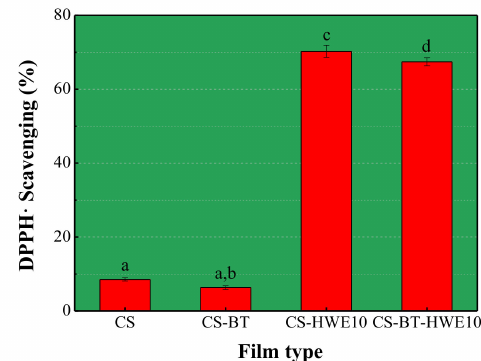
Figure 3. DPPH scavenging ability of the pure chitosan and composite films ( n = 3). Values are given as mean ± standard deviation. Di ff erent letters indicate significantly di ff erent ( p < 0.05) when analyzed by the Tukey test.